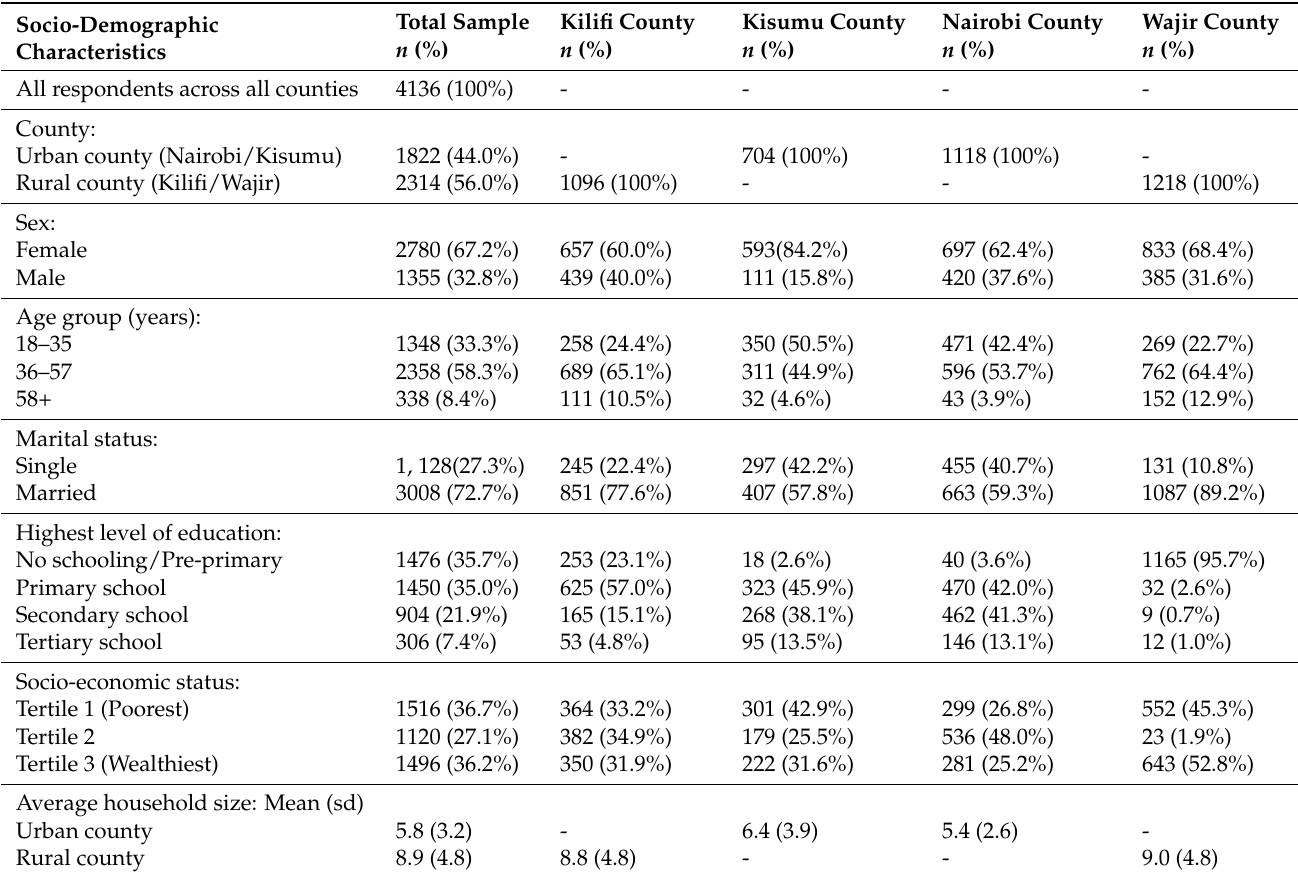
Table 2. Socio-demographic characteristics by county.